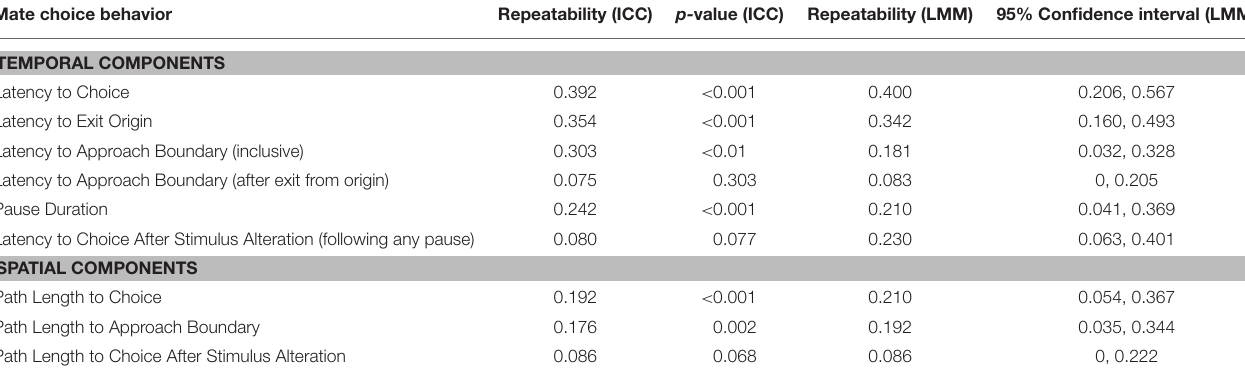
TABLE 1 | Repeatabilities of the temporal and spatial components of mate choice assays. Mate choice